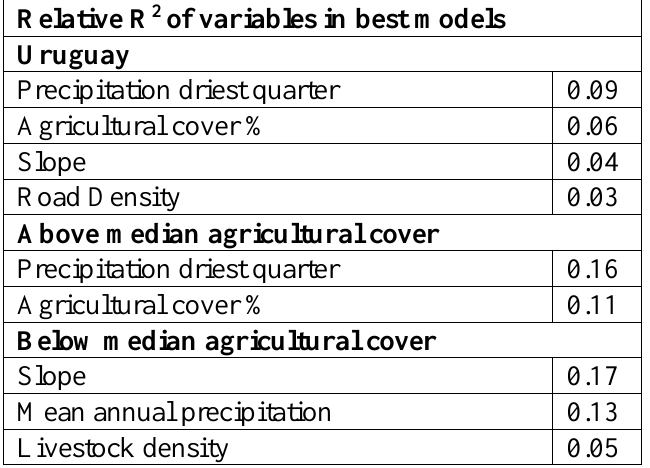
Table A1.3. Relative R 2 of variables in the best